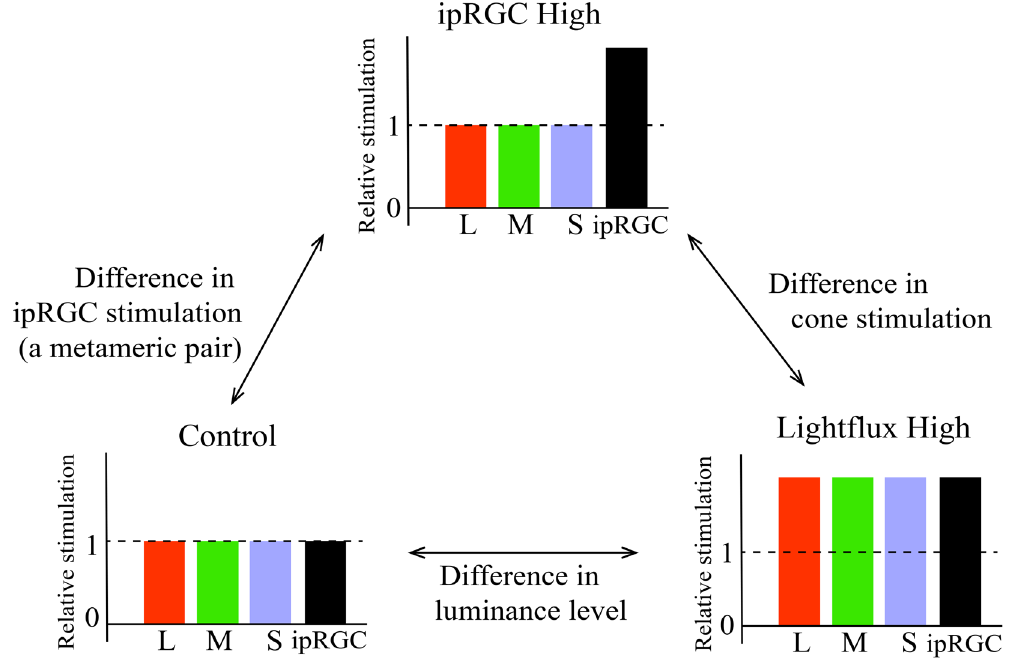
Figure 4. Three conditions in Experiment 2. Three conditions were manipulated, including ipRGC High condition, Control condition, and Lightflux High condition, and every two of the three conditions could be compared to examine the influence of ipRGC as well as cone stimulations (i.e., luminance). For the x-axis, “L”, “M”, and “S” refer to stimulations of the three kinds of cones: Long-wavelength, Middle-wavelength, and Short- wavelength